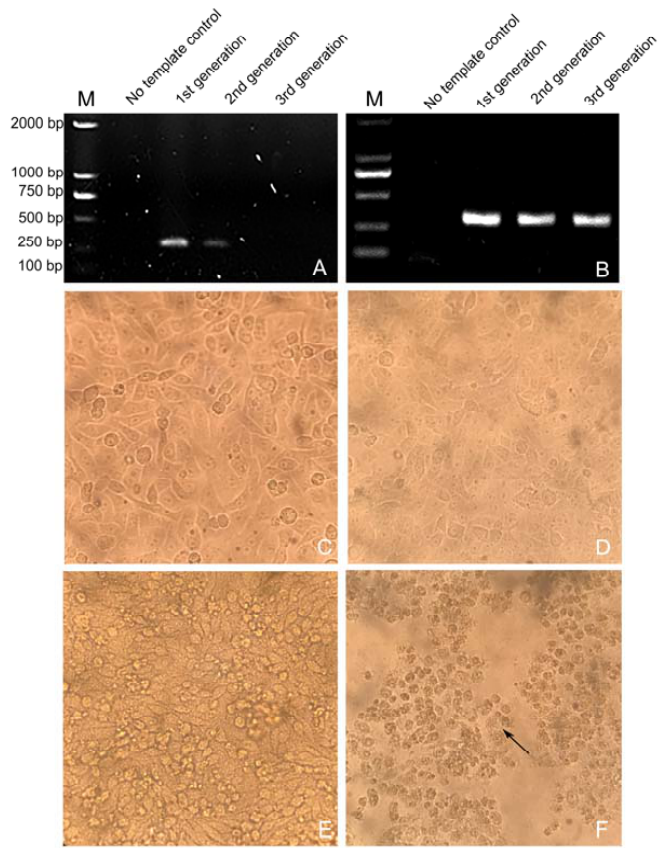
Figure 1. Isolation and identification of PEDV strain NJ in Vero cells and intestinal epithelial cell (IEC) cultures. ( A ) Identification of PEDV cultured in Vero cells at serial passages, by reverse transcription PCR (RT-PCR); ( B ) Identification of PEDV cultured in IEC at serial passages, by RT-PCR; ( C ) Control (uninfected) Vero cells; ( D ) PEDV-infected Vero cells; ( E ) Control (uninfected) IECs; ( F ) PEDV-infected